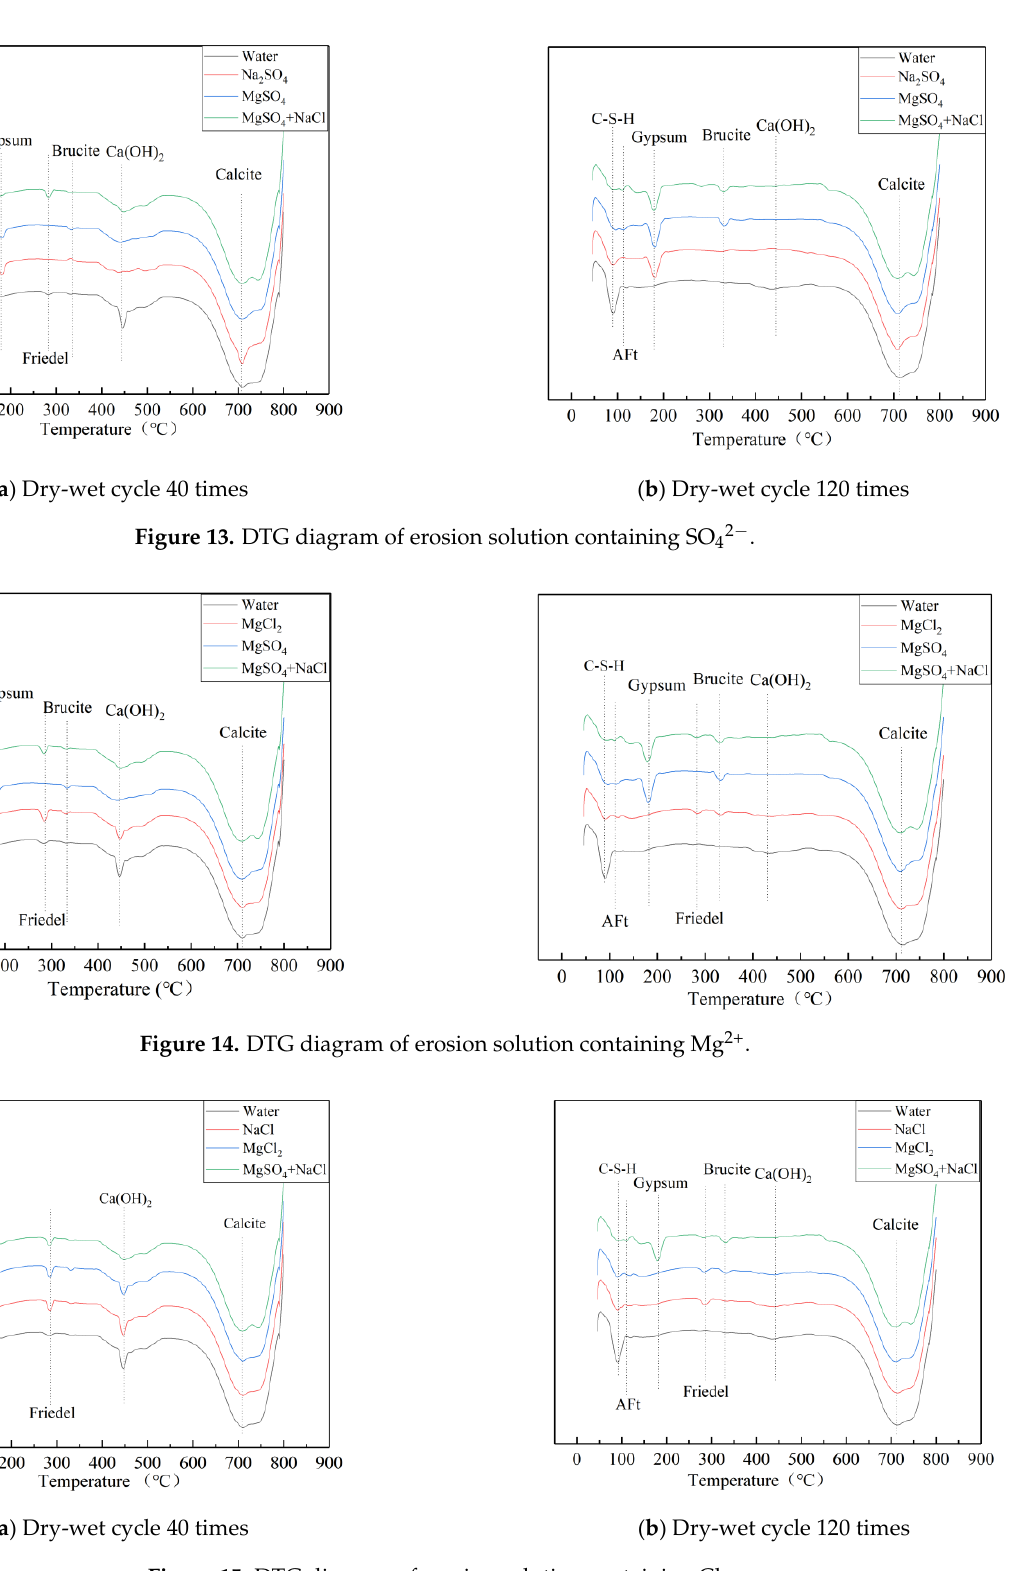
Figure 15. DTG diagram of erosion solution containing Cl − .